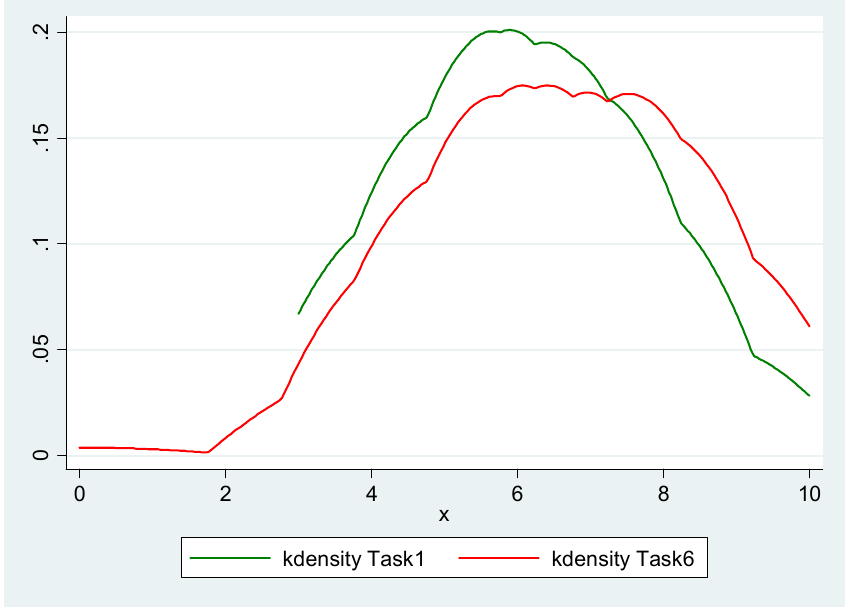
Figure A5. Kernel densities of the number of safe choices (i.e., switching points in the H&L tasks). Selected by the subjects, which represent the distributions of the degrees of risk aversion.